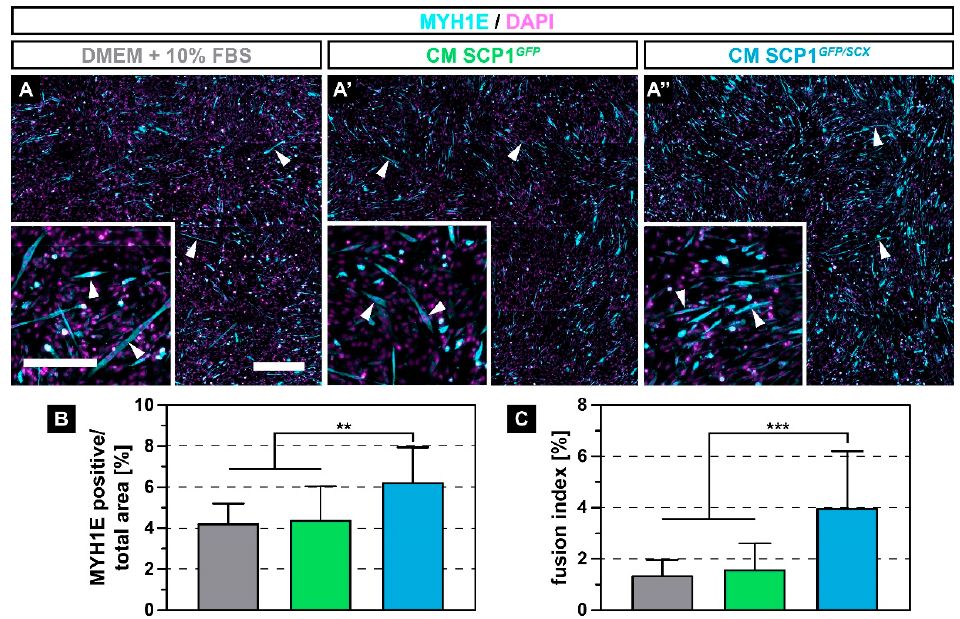
Figure 3. Immunohistochemistry against myosin heavy chain 1E (MYH1E) (turquoise) after 5 days of myogenic di ff erentiation showed newly fused myotubes in all culture conditions ( A–A” , arrowheads). However, myoblasts that were exposed to conditioned medium (CM) derived from SCP1 GFP / SCX cells showed an increased fusion, when compared to C2C12 in NM or CM of SCP1 GFP cells (A-A”). Quantification of the MYH1E positive area ( B ) and the fusion index ( C ) validated the microscopic appearance. Scale bars: 500 µ m (overview), 200 µ m (insert). Bar plots represent the mean and SD. ** equals p ≤ 0.01, *** equals p ≤ 0.001. Five randomly selected pictures of three independent experiments were